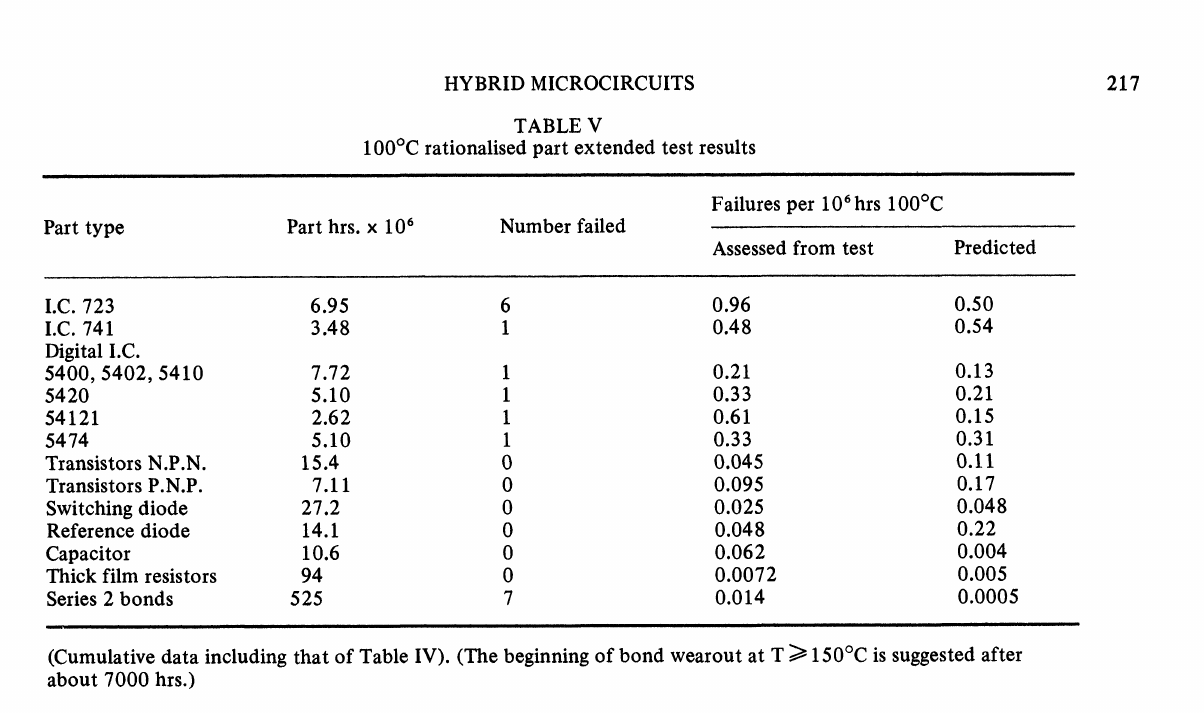
TABLE V 100C rationalised part extended test